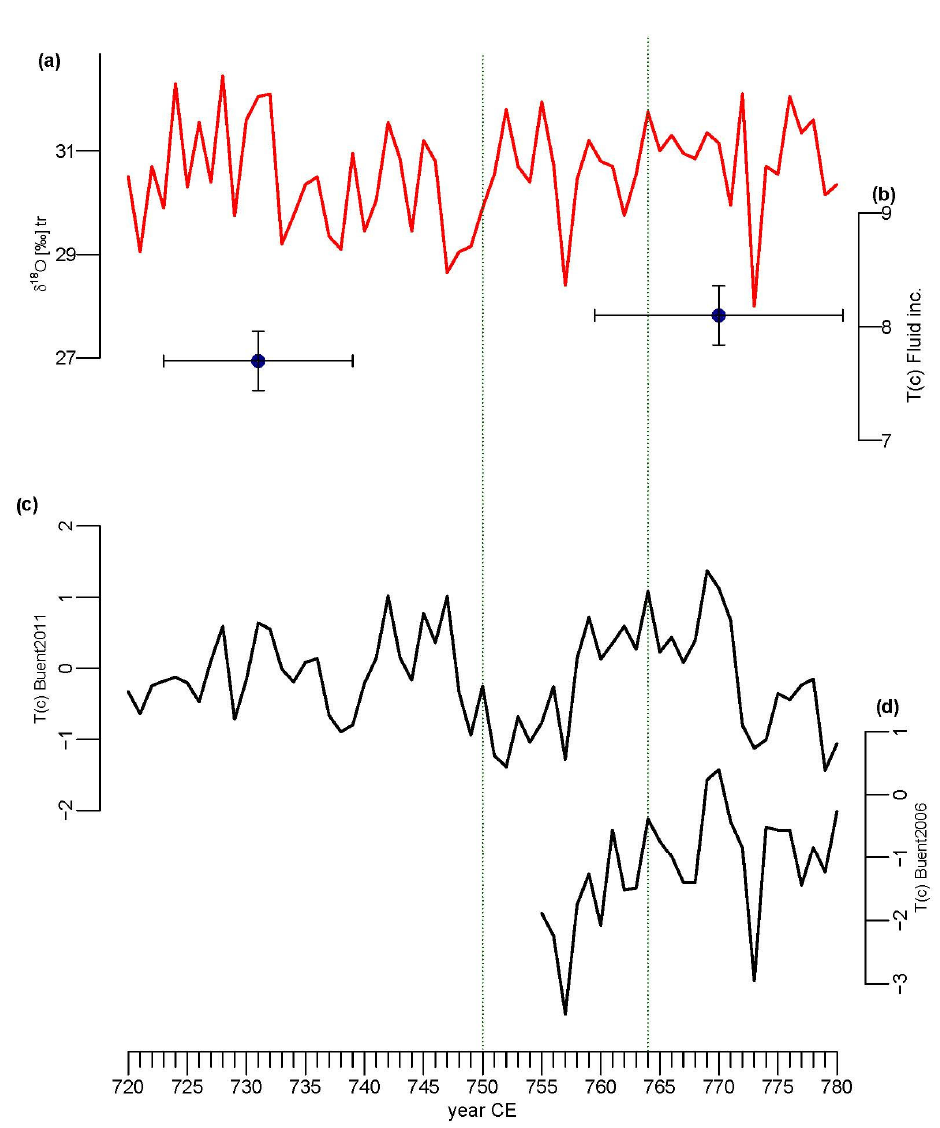
Figure 5. Comparison between the trend of the oxygen isotope series and those of other climate proxies in mid-8th-century eruptions attributed to Icelandic volcanoes: ( a ) Average series of the δ 18 O values of the two trees with annual resolution. ( b ) Temperature from the speleothem fluid inclusions from Milandre Cave. ( c ) Reconstructed temperature evolution based on TRW by [69] ( d ) Reconstructed summer temperature based on MDX by [70].